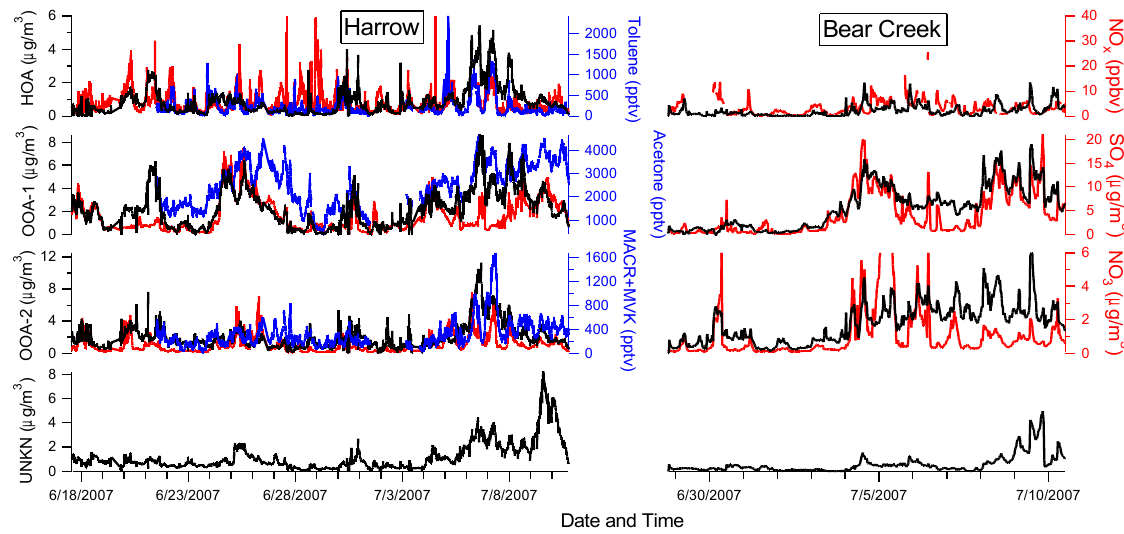
Fig. 2. Factor time series for the 4-factor PMF solution to the combined Harrow/Bear Creek dataset obtained at f Peak=0.5. The figure also includes selected tracer species (blue and red